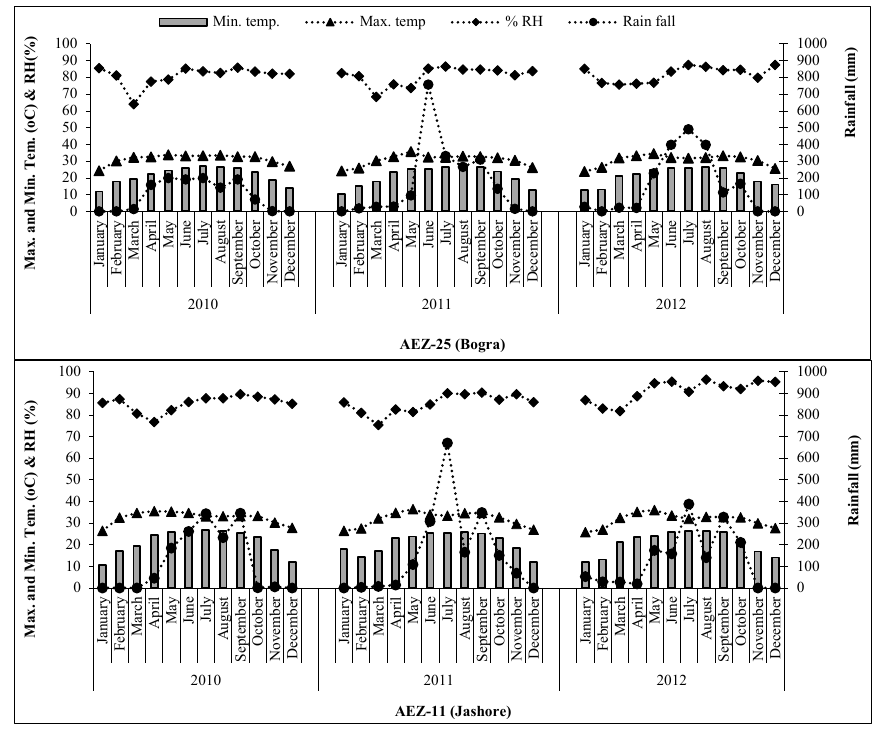
Figure 1: Weather information during rice growing season during 2010 to 2012in Bogra (AEZ-25) and Jashore (AEZ-11) sites in Bangladesh